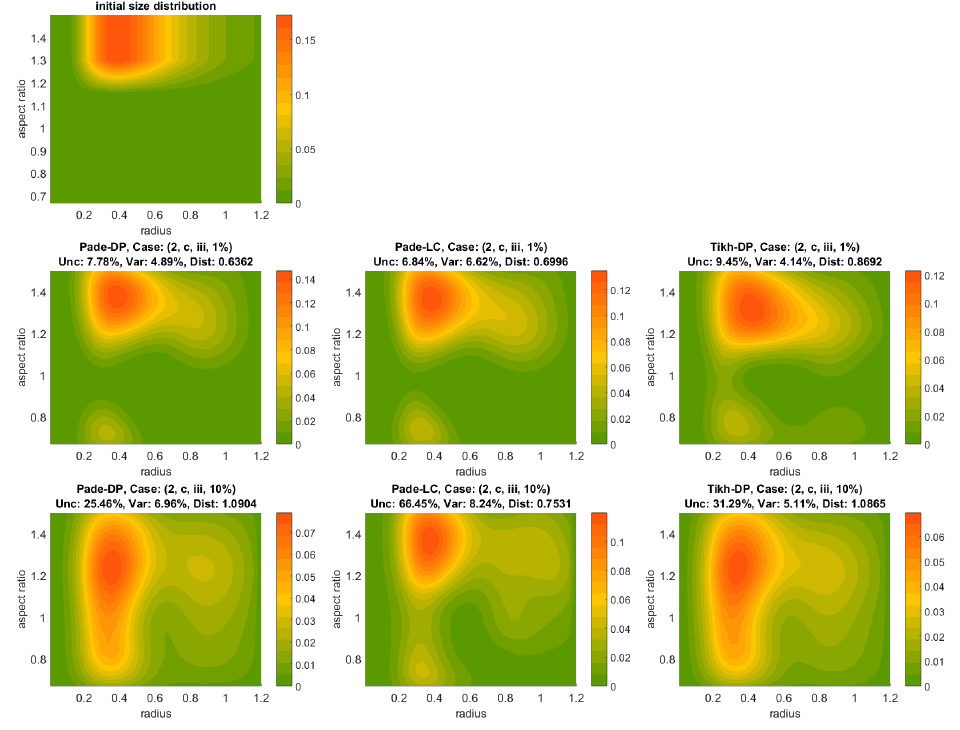
Figure 3. Shape-size distribution reconstructions produced by Padé-DP, Padé-LC and Tikh-DP (left to right) for the case (2, c, iii), respectively, for 1% and 10% error level. The uppermost plot corresponds to the initial shape-size distribution. The triple (Unc, Dist, Var) in the title of each plot refers to error-related quantities of shape-size